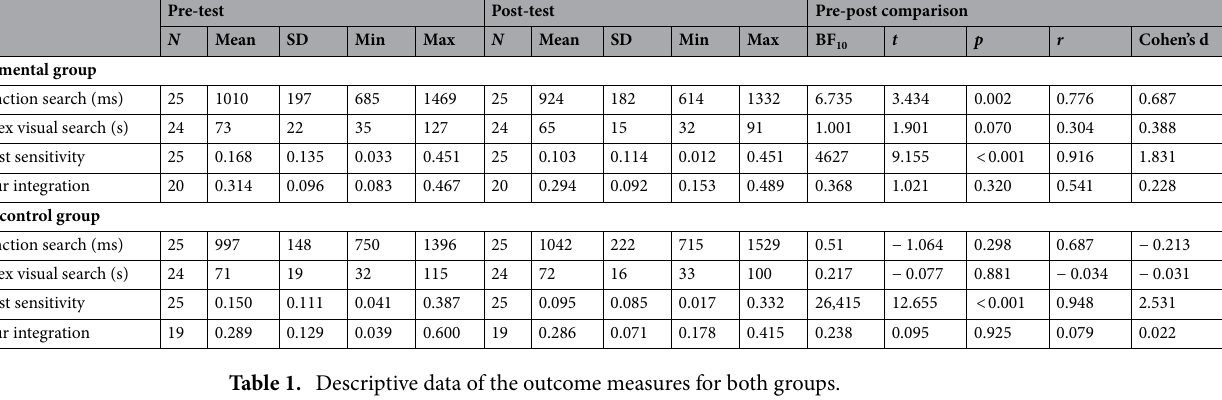
Table 1. Descriptive data of the outcome measures for both groups.